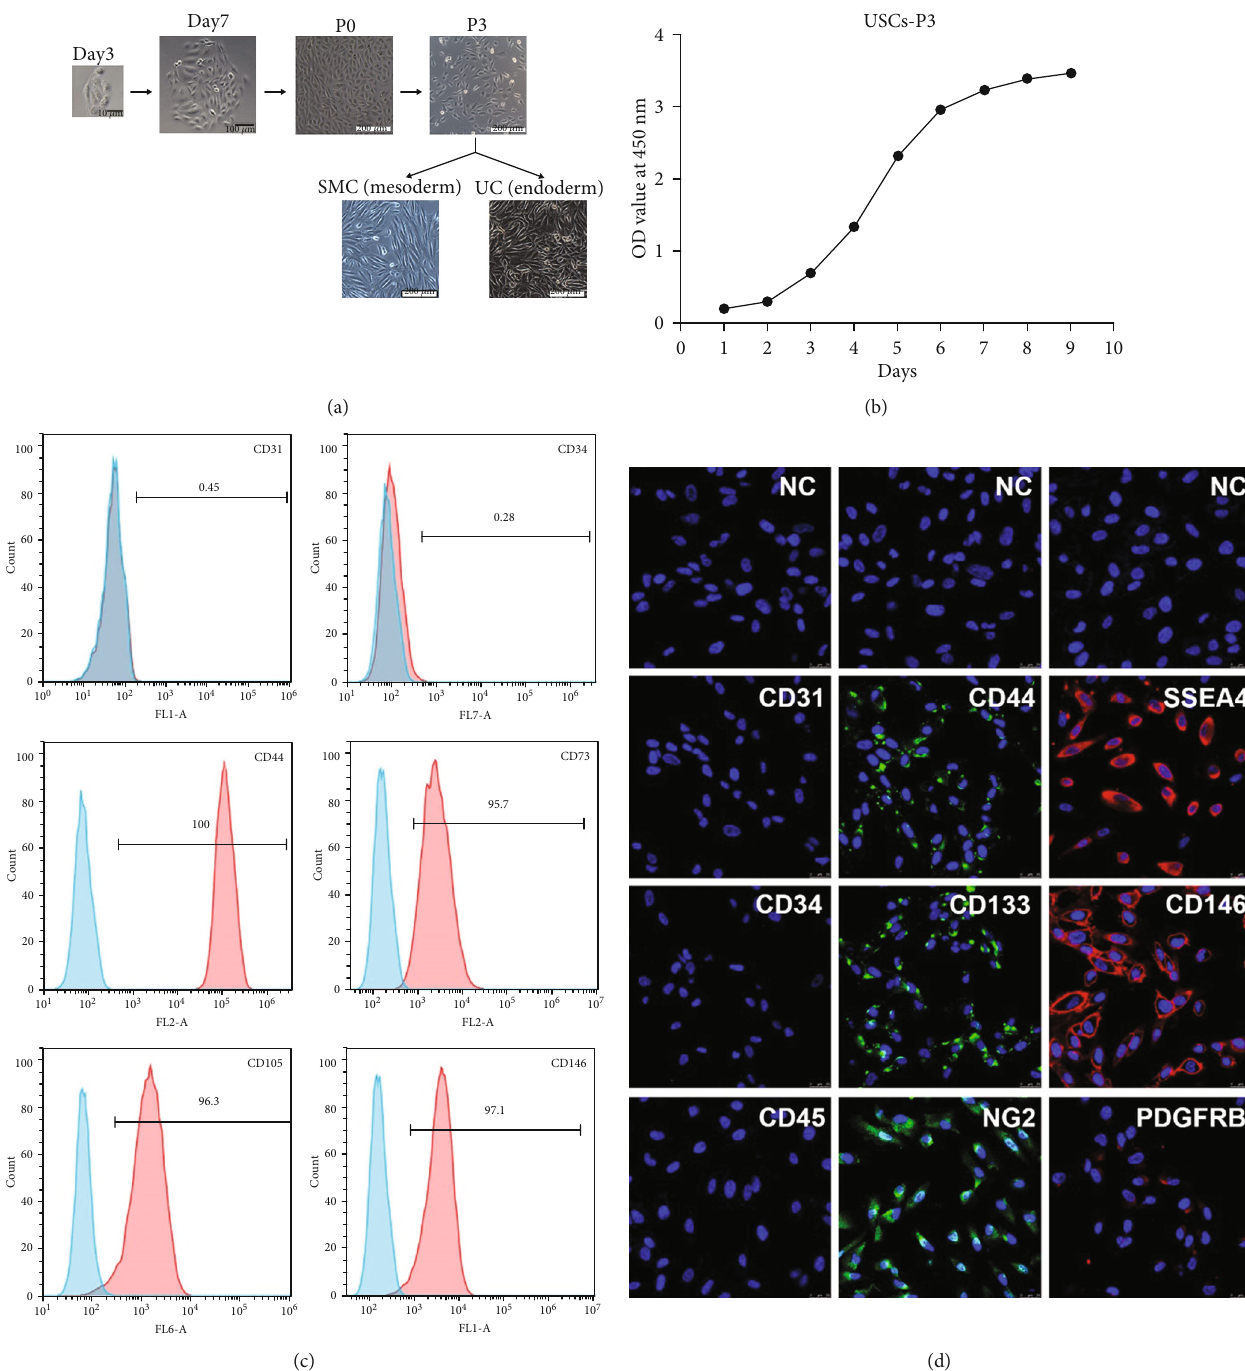
Figure 1: Growth characteristics of USCs. (a) The morphology of USCs by passage and di ff erentiation. Single, small, compact rice grain-like cells were observed on the third day after initial seeding, and they formed a colony on the seventh day. The cells were considered to be at P0 when the con fl uence reached 70-80% and were passaged to the next generation. The USCs maintained the rice grain-like morphology after several passages, and USCs from the P3 generation were induced to di ff erentiate into SMCs and UCs. The cells showed an elongated and spindle-shaped morphology after SMC di ff erentiation and a cobblestone-shaped morphology after UC di ff erentiation. Scale bar: 50 μ m, 100 μ m, and 200 μ m. (b) The growth curve of USCs from the P3 generation. (c) Detection of surface markers in USCs using fl ow cytometry. USCs did not express hematopoietic stem cell markers (CD31: 0.45%, CD34: 0.28%) but expressed MSC markers (CD44: 100%, CD73: 97.1%, and CD105: 96.3%) and pericyte markers (CD146: 95.7%). (d) Detection of surface markers in USCs using IF. USCs did not express hematopoietic stem cell markers (CD31, CD34, and CD45) but did express MSC markers (CD44 and CD133), the ESC marker SSEA4, and pericyte markers (CD146, PDGFRB, and NG2). NC: negative control; PDGFRB: platelet-derived growth factor beta- receptor; NG2: neural/glial antigen 2. Scale bar: 25 μ